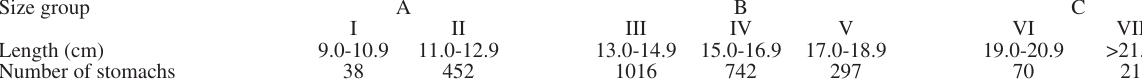
Table 2. – Prey items reported as index of relative importance (IRI %) for the seven size classes. The three size groups (A, B and C) identified by the cluster analysis are indicated. Size